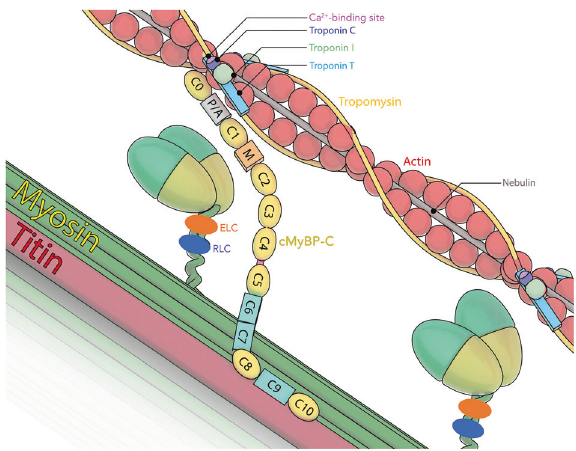
Fig. 1 Diagram of cMyBP-C interactions with thick and thin fi laments in sarcomeres. The C ’ -region (C8-C10) anchored in light meromyosin and titin localizes and stabilizes the MyBP-C protein. The N ’ -region (C0-C2) binds to either the myosin head or actin/ tropomyosin and regulates the kinetics of actomyosin interaction and calcium sensitivity.